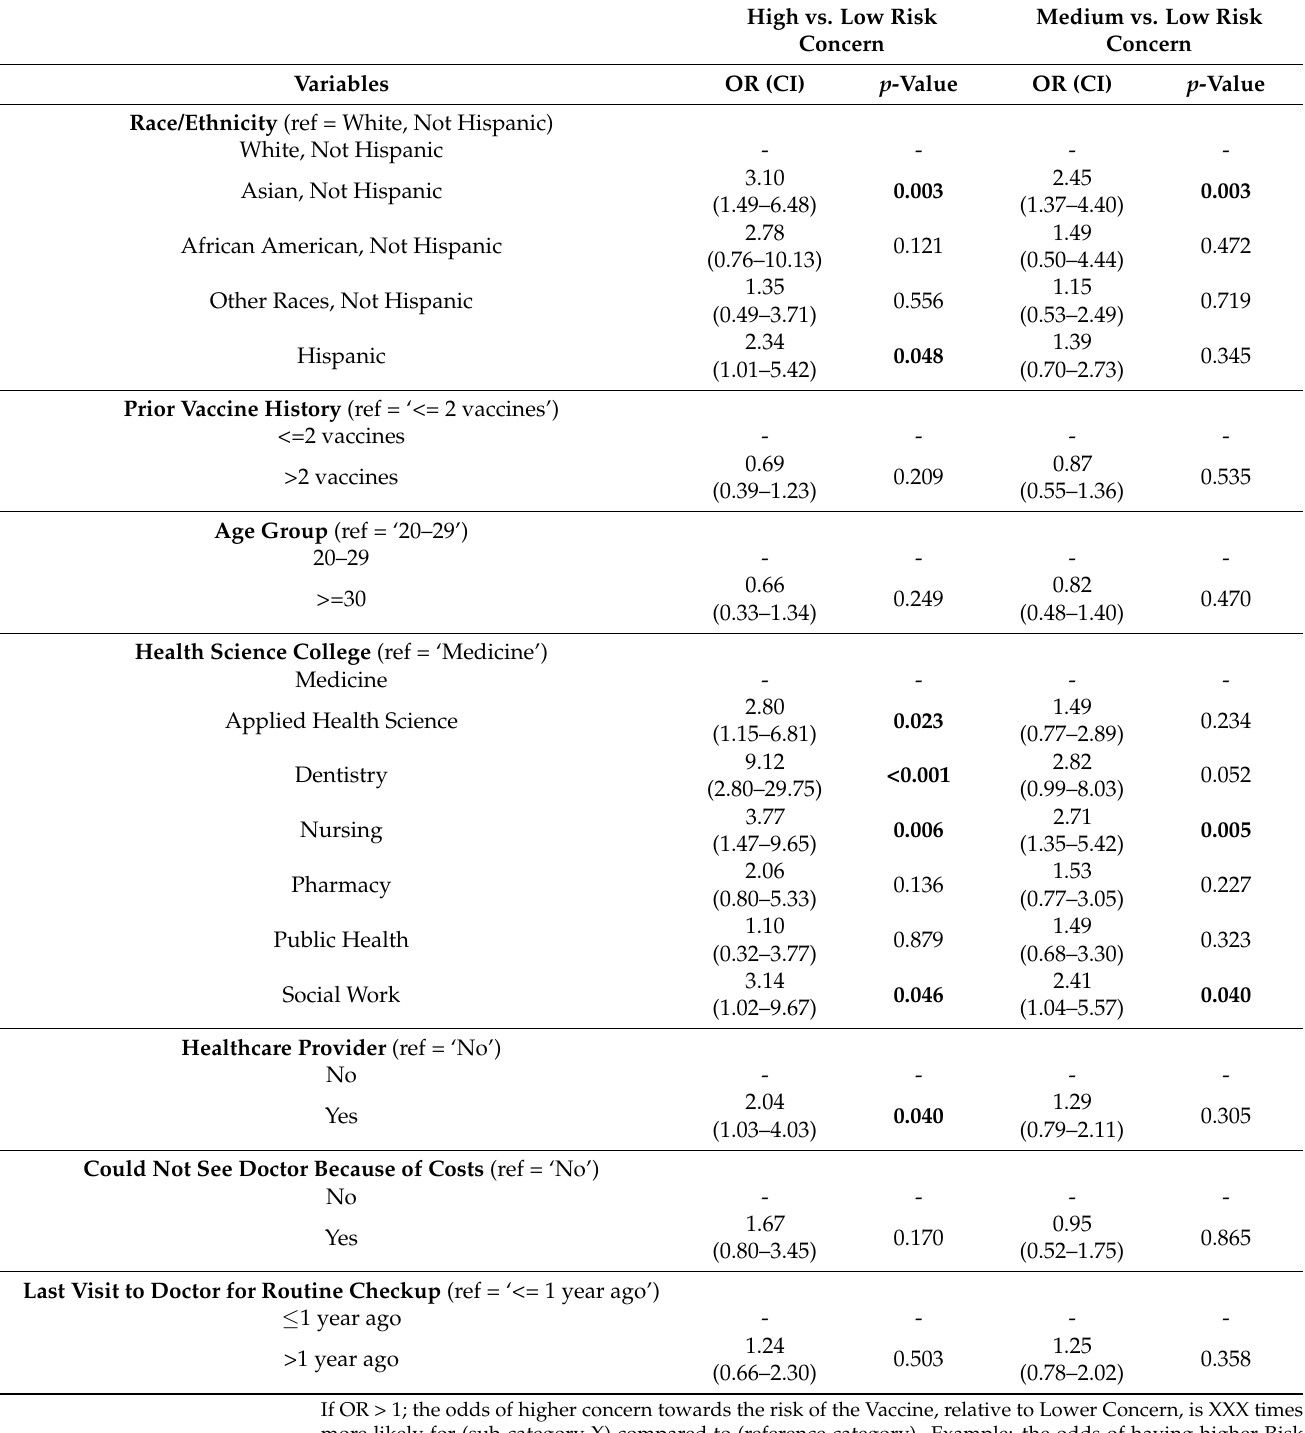
Table 7. Multinomial logistic regression on risk concern scoring